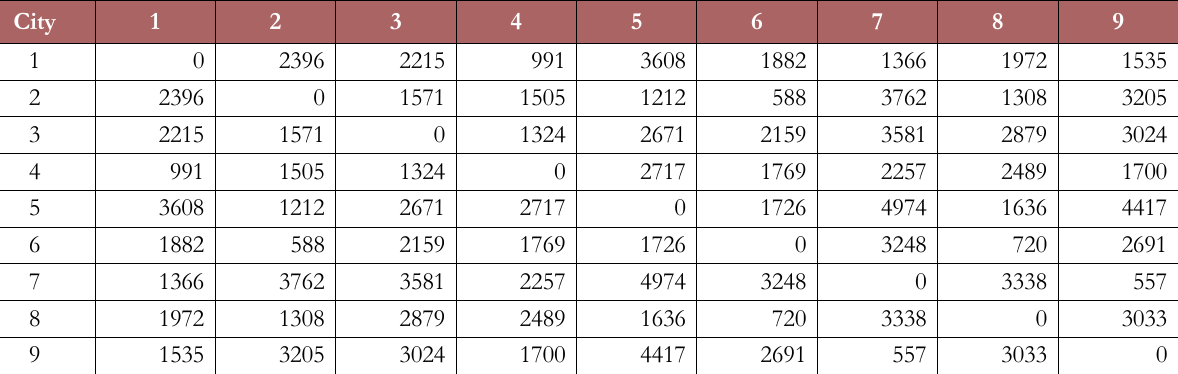
Table 2. Distance matrix for the hypothetical example